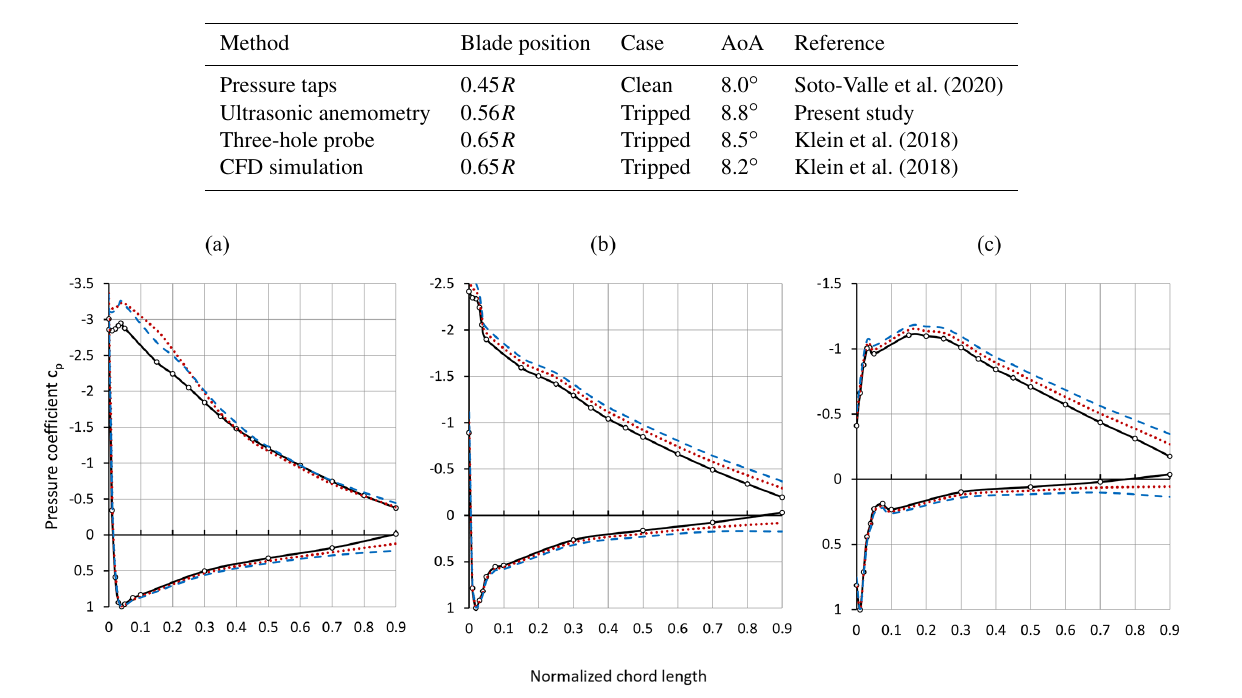
Figure 9. Pressure coefficients in the tripped case with respect to different scales at r = 0.45 R and ϕ = 270 ◦ . (a) TSR = 3.0. (b) TSR = 4.3. (c) TSR =